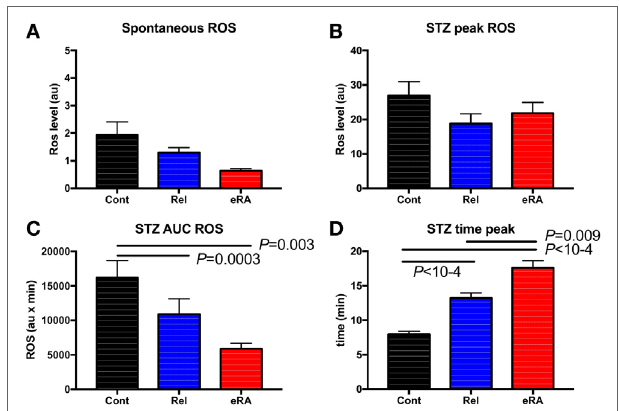
FigUre 2 | Granulocyte reactive oxygen species (ROS) production: spontaneous (a) , after serum treated zymozan (STZ) stimulation at peak (b) , area under the curve (AUC) (c) , and time to reach peak ROS production (D) . Healthy controls (Cont), rheumatoid arthritis (RA) first-degree relatives (Rel), and untreated RA patients at onset (early RA). Statistics are indicated when P ≤ 0.05.